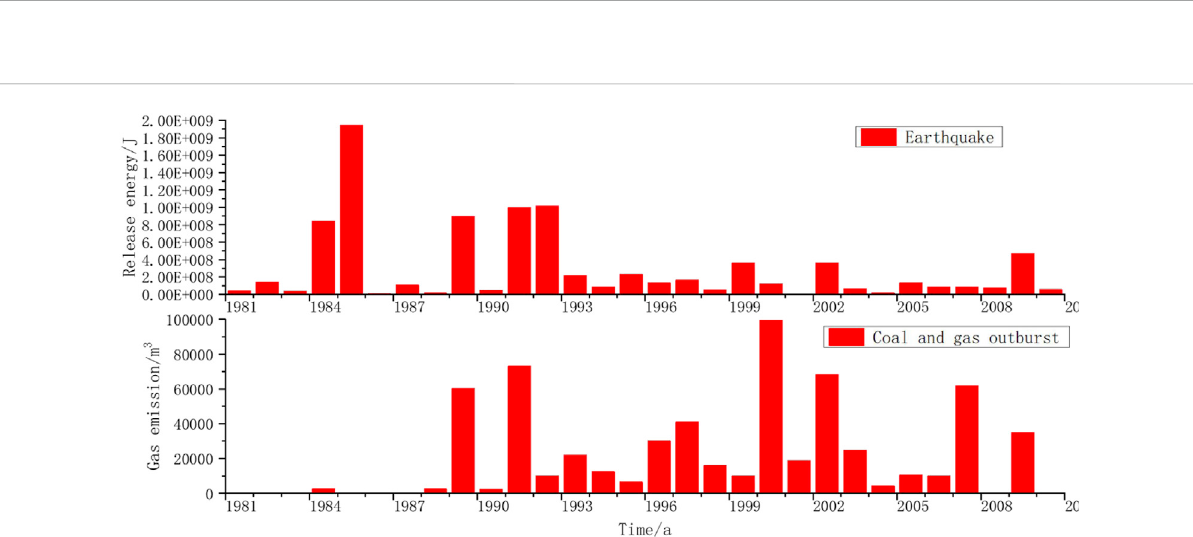
Frontiers in Earth